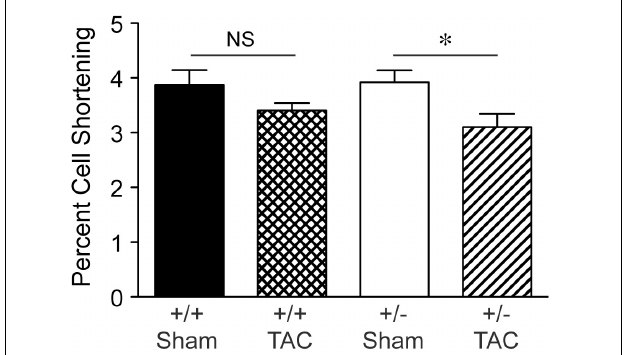
FIGURE 7 | Decrease in percent cell shortening of Speg + / − cardiomyocytes after TAC. Quantitative data for cell shortening of isolated cardiomyocytes from the LV of Speg + / + and Speg + / − mice exposed to TAC or sham for 4 weeks (Speg + / + sham n = 124 from 4 mice; Speg + / + TAC n = 199 from 5 mice; Speg + / − sham n = 140 from 5 mice; Speg + / − TAC n = 83 from 3 mice). Data are shown as mean ± SEM. Analysis by one-way ANOVA using Kruskal–Wallis test ( P < 0.05), with significant comparison ∗ Speg + / − TAC versus Speg + / − sham. NS, not